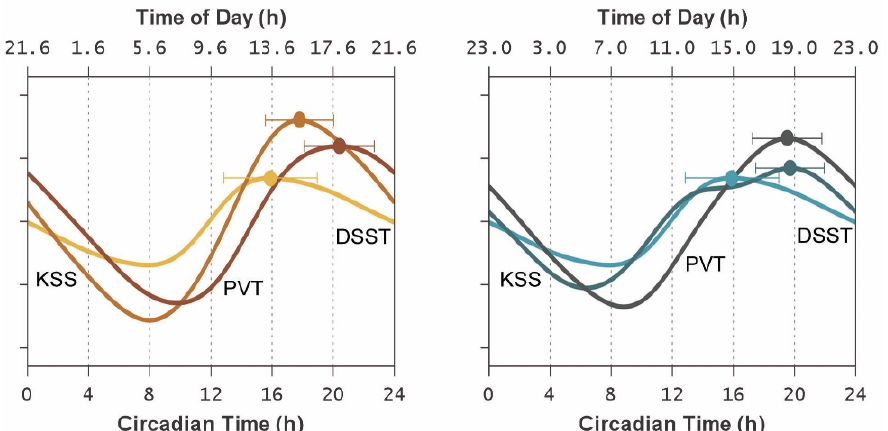
Figure 4. Endogenous circadian rhythm contributions to neurobehavioral functioning during the 24 h CR protocol. The graphs show the mean (accounting for inter-individual differences) of the circadian component of the fitted statistical model of Equation (5), plotted against circadian time (i.e., relative to DLMO) on the bottom axes and against corresponding mean clock time on the top axes. Curves represent the endogenous circadian rhythm influence on each of the three neurobehavioral outcomes after normalization (i.e., as z scores, to make them comparable in vertical scale) for the simulated day shift condition ( left ) and the simulated night shift condition ( right ) using the same color scheme as in Figure 3. Upwards indicates greater circadian drive (corresponding with better neurobehavioral functioning). The secondary bump in the KSS curve in the simulated night shift condition (around 14 h after DLMO) is a result of convolution of the subject-specific circadian rhythm contributions encompassed in the mean. Dots and whiskers represent the task-specific circadian peaks and their 95% confidence intervals. Note the relatively tight clustering of the peaks, regardless of condition, in the late biological afternoon (approximately 16–20 h after DLMO).